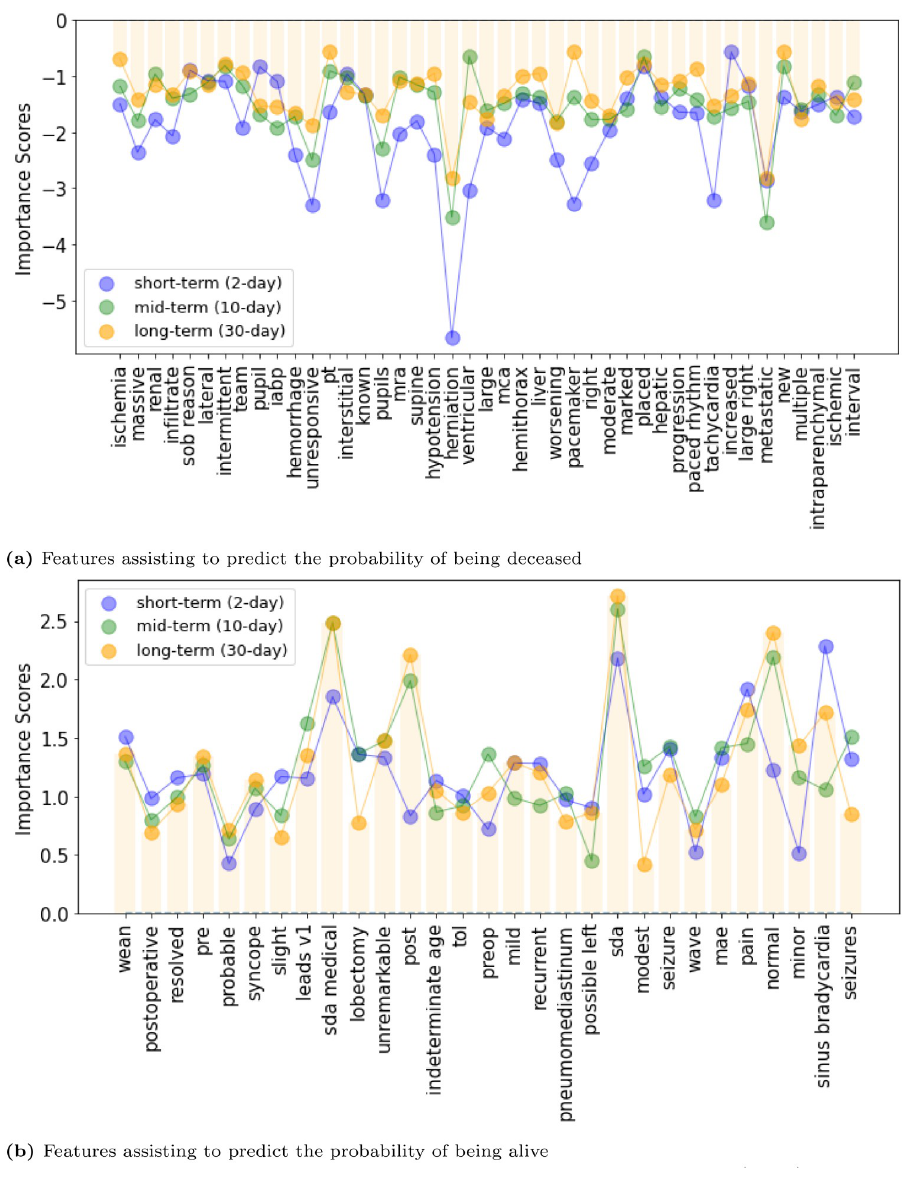
Fig 8. Importance of the features that remained significant over short/mid/long-term prediction windows. These features are from the logistic regression with